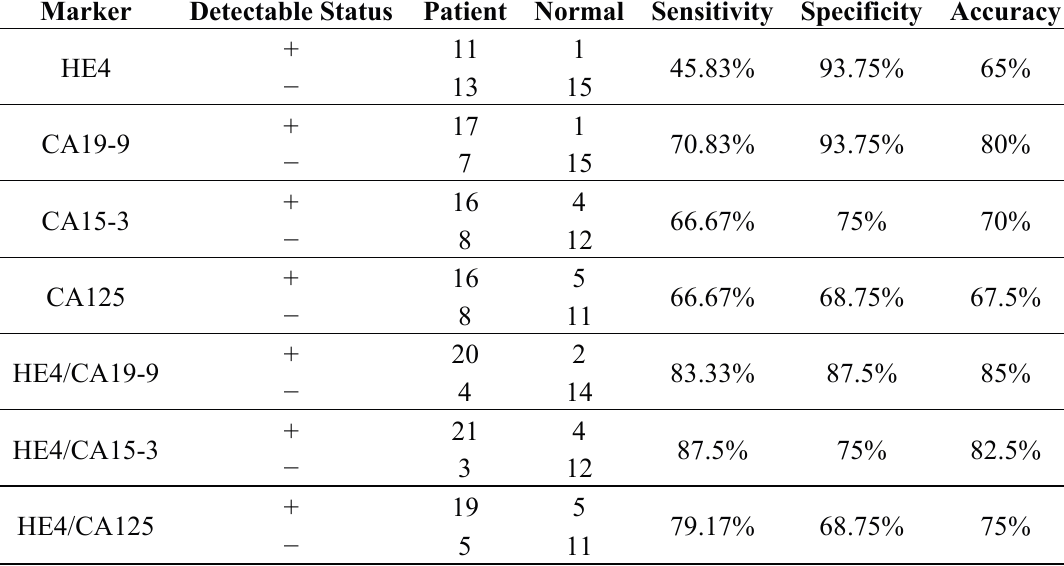
Table 5. Summary of sensitivity, specificity and accuracy of each biomarker alone or in combination with HE4. The accuracy of each marker was calculated and shown in the table. The sensitivity, specificity and accuracy of the combination of HE4 with CA19-9, CA15-3 and CA125, respectively, were calculated and listed in the table. An increased sensitivity of combination compared to the two serum marker alone was observed in the three combination groups (HE4/CA19-9, HE4/CA15-3, and HE4/CA125). Each serum protein level was classified as detectable level (+) and undetectable level ( − ) status, the case numbers of (+) and ( − ) from cancer patients group and normal group were summarized in